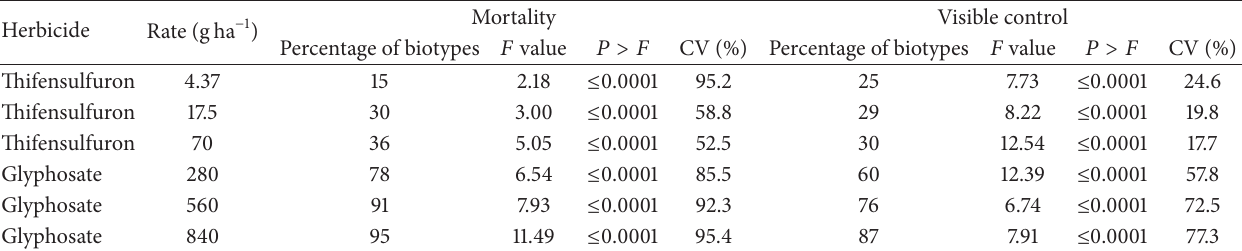
and thifensulfuron based on Dunnett’s Procedure ( 𝑃 ≤ 0.05